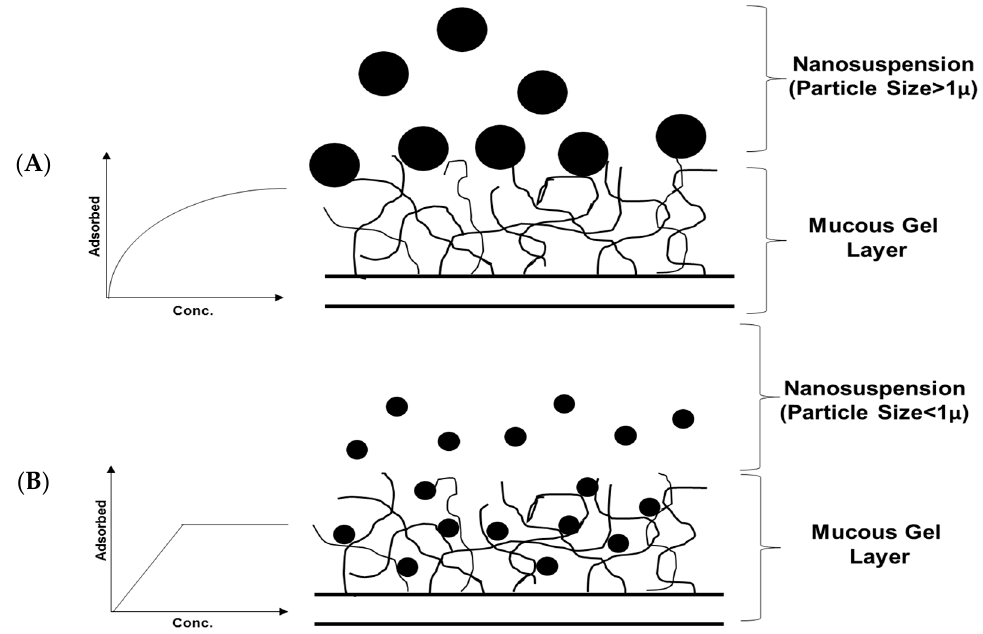
Figure 3. Adsorption Isotherms in case of ( A ) Particle Size Greater than 1 μ ; ( B ) Particle Size Lesser than 1 μ